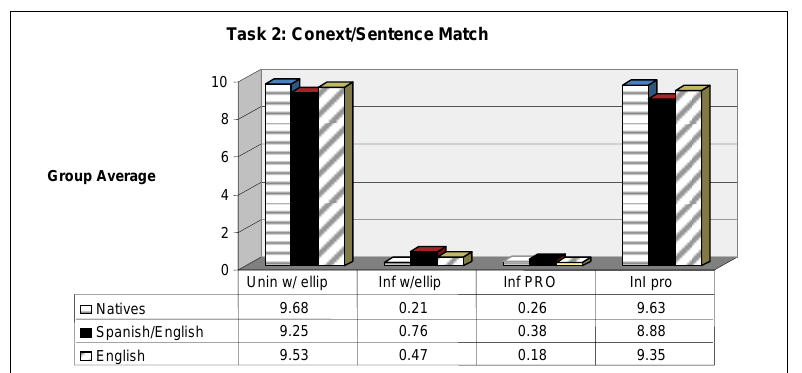
Figure II: Results from Task